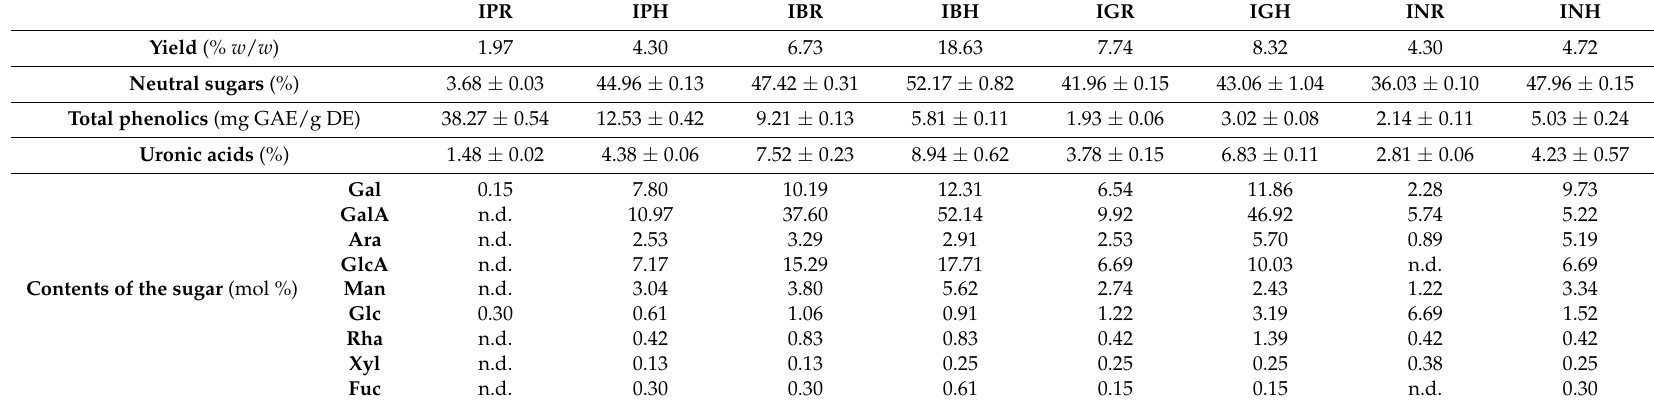
IPR, I. parviflora roots; IPH, I. parviflora aerial parts; IBR, I. balsamina roots; IBH, I. balsamina aerial parts; IGR, I. glandulifera roots; IGH, I. glandulifera aerial parts; INR, I. noli-tangere roots; INH, I. noli-tangere aerial parts; Gal, galactose; GalA, galacturonic acid; Ara, arabinose; GlcA, glucuronic acid; Man, mannose; Glc, glucose; Rha, rhamnose; Xyl, xylose; Fuc, fucose; content of the sugars is expressed in mol % related to the total content of the monosaccharides; % w/w, yield related to the dried plant material; the total phenolic content is expressed as gallic acid equivalents; n.d., not